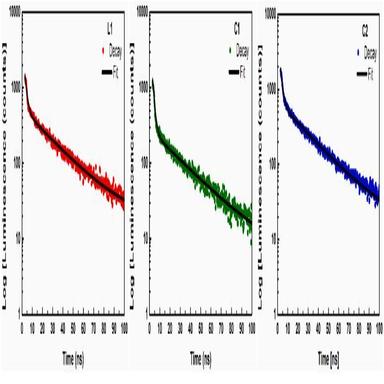
Photoluminescence decays for stilbene-based iminopyridine L1, C1 and C2 thin films.